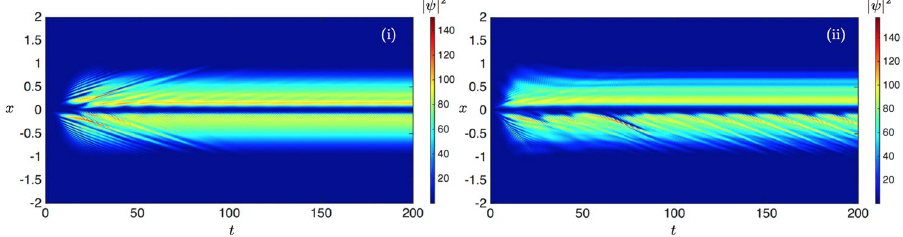
Figure 6. Density plots | ψ ( x , t )| 2 of the condensate wave function predictions for the case dynamics with k sensitive mass ( i ) and for the full lower polariton dispersion with a weak self-interaction strength. In the simulations a 4 th order time splitting in time with Δ h = 0.005, Δ t = 0.005 was used. A very large domain [ − 50, 50] was employed to make sure the value of the solution on the boundary is negligible. Numerical parameters were α = 0.001, V